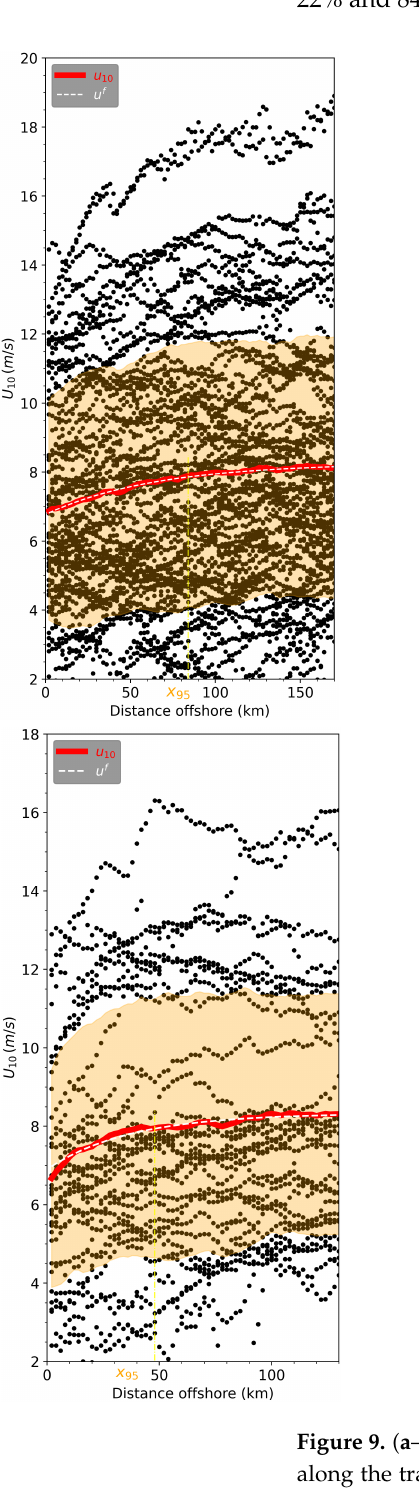
are displayed 10 ( f ). The red, yellow and white dashed 10